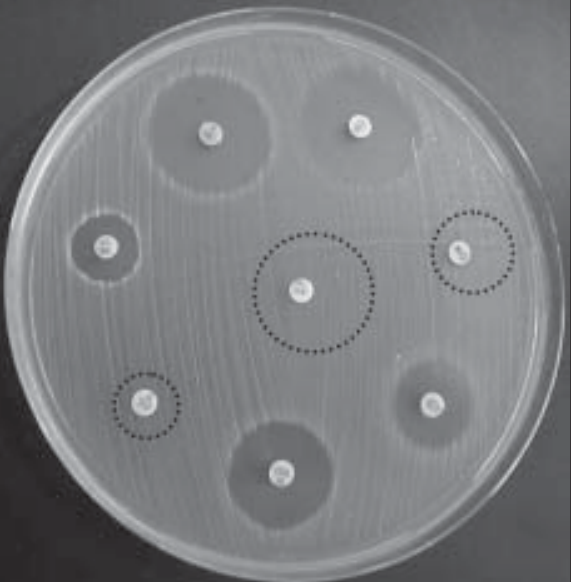
Figura – Avaliação dos discos dos antimicrobianos ciprofloxacina (CP), clindamicina (CL), eritromicina (ER), gentamicina (GN), oxacilina (OX), penicilina (PN), rifampicina (RF) e vancomicina (VN) da marca Pimenta Abreu ® empregando-se a cepa de Staphylococcus aureus ATCC 25923. Foram observadas reduções acentuadas nos diâmetros dos halos de inibição para os antimicrobianos oxacilina, penicilina e